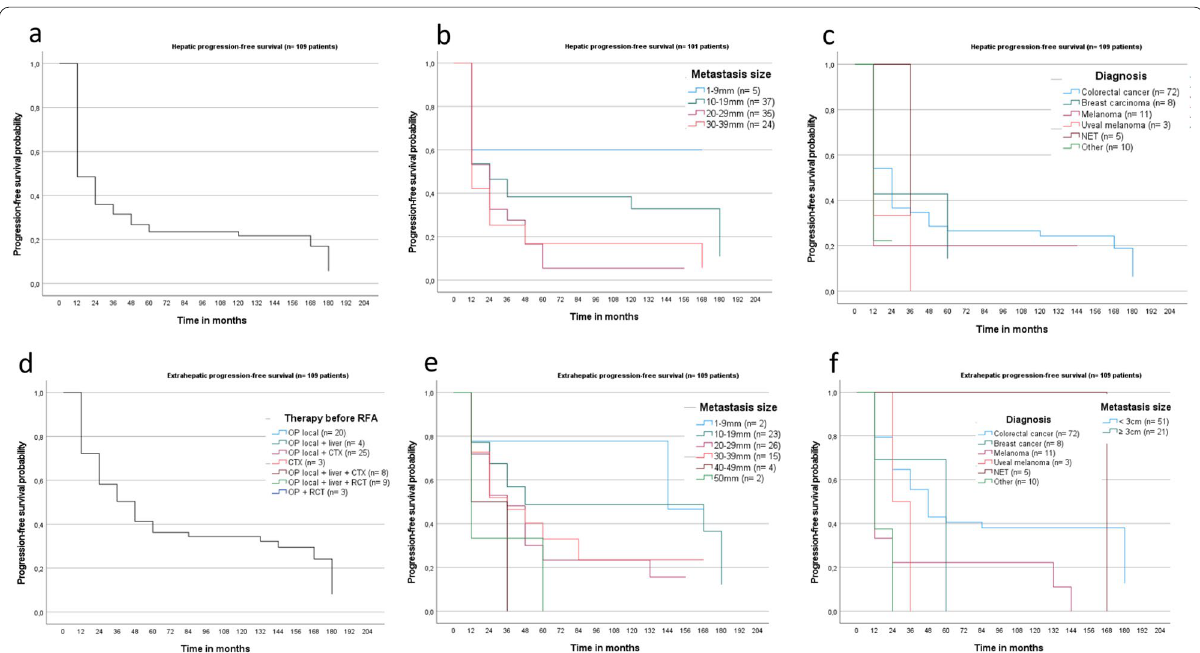
Fig. 3 Kaplan–Meier curve depicts hepatic PFS of the whole study cohort in 73/109 patients (66.9%; a ). Thereof, RFA treated lesions up to 29 mm, revealed longer hepatic PFS, compared to lesions over 30 mm ( b however not statistically significant p the highest hepatic PFS ( c median 24.2 and 13.0 months, SD 3.9, 95% CI 5.2–20.9). Lowest hepatic PFS showed melanoma patients ( c median 4.1 months, SD 2.1; 95% CI 0.1–8.2). Extrahepatic PFS of the whole study cohort occurred after median 37.0 months ( d SD 9.3; 95% CI 18.7–55.2). Thereof highest extrahepatic PFS was documented for RFA‑treated lesions up to 9 mm ( e median 135.2 months, SD 96.2; 95% CI 0–323.9) and for patients with NET ( f median 156.5